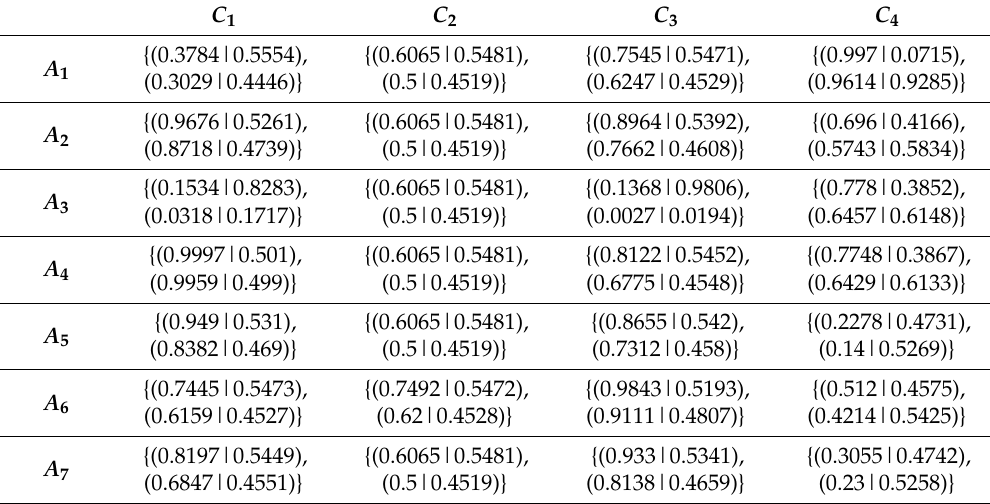
Table 12. Probabilistic Hesitant fuzzy decision matrix.